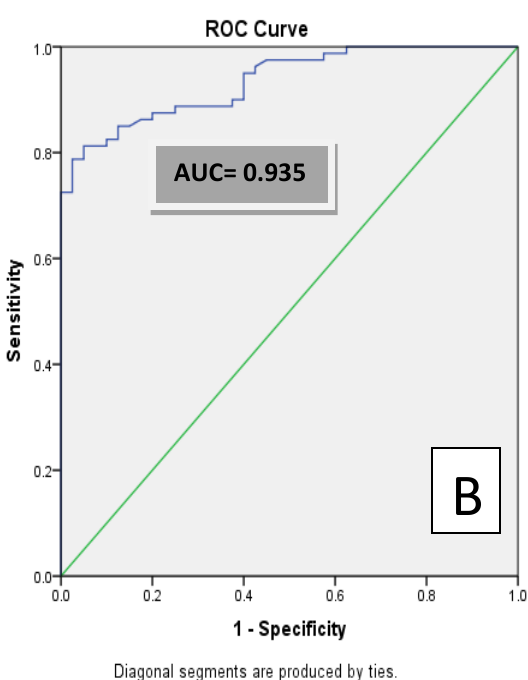
Figure 2 : ROC curves for serum myelin protein in type 2 diabetic Patients A) ROC curves for serum MPZ B) ROC curves for serum